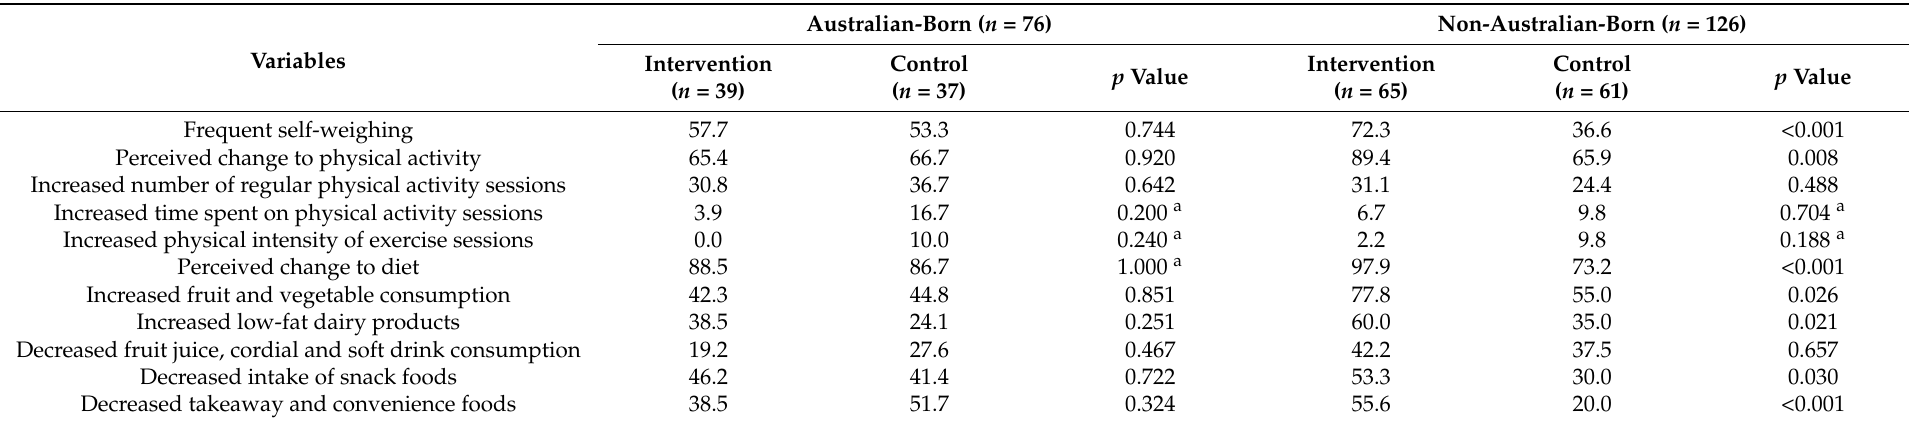
Table 3. Other behavioral measures at 6 weeks